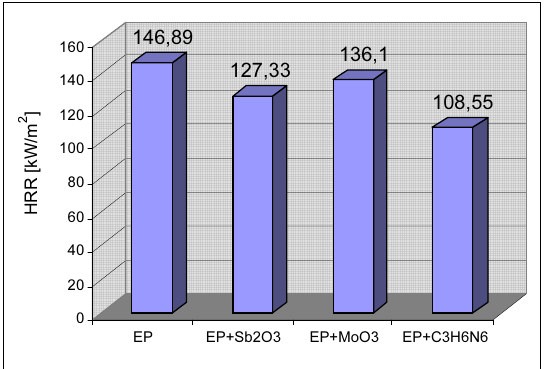
Fig 4. The average value of heat release rate of